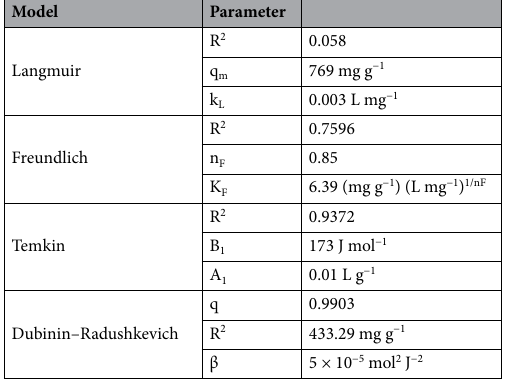
Table 2. Fitting of experimental data with theoretical isothermal models. Fitting of different isothermal models for adsorption of DCF on TPEG.